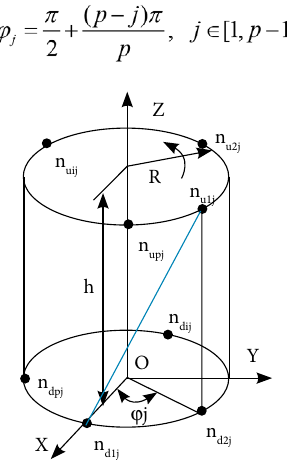
Figure 2. Node distribution